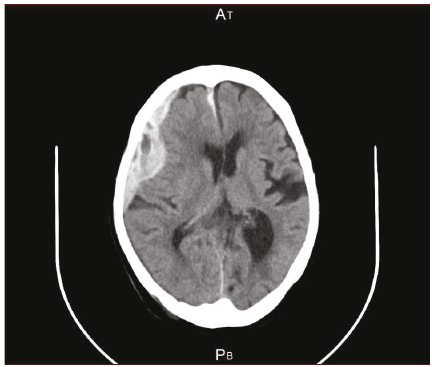
Figure 2: Magnetic resonance imaging of the horizontal section at the frontal lobe of the cerebrum.